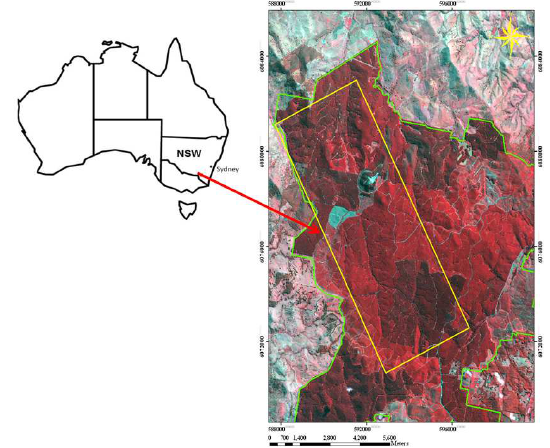
Figure 1. The study area shown on false colour composite SPOT-5 image; the yellow rectangle shows the boundary of 5000 ha study area used for this research while the green line shows a part of Green Hills FS